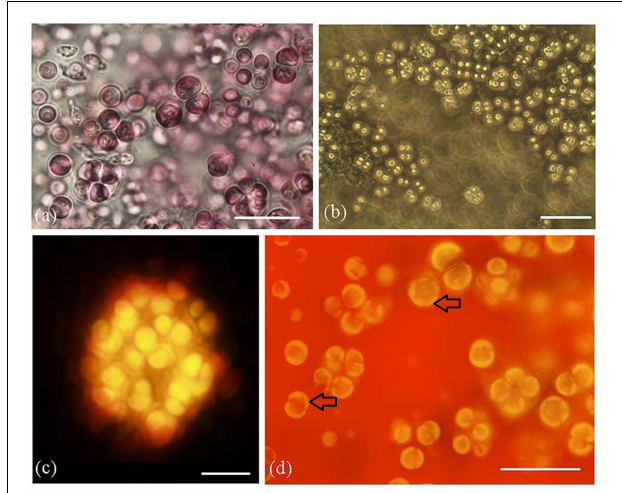
FIGURE 2 | Rhodosorus marinus cultures. (a) light photomicrograph; (b) phase-contrast photomicrograph; (c) auto-fluorescence of cluster of cells shown from above in (2a); (d) autofluorescence of cells, showing 2–5 chloroplast lobes (black arrows). Scale bars: (a) = 20 µ m, (b) = 35 µ m, (c) = 10 µ m, (d) = 20 µ